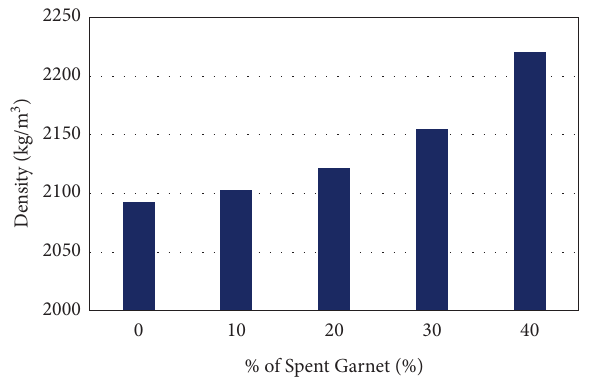
Figure 6: Oven dry density of POC LWAC containing spent garnet.